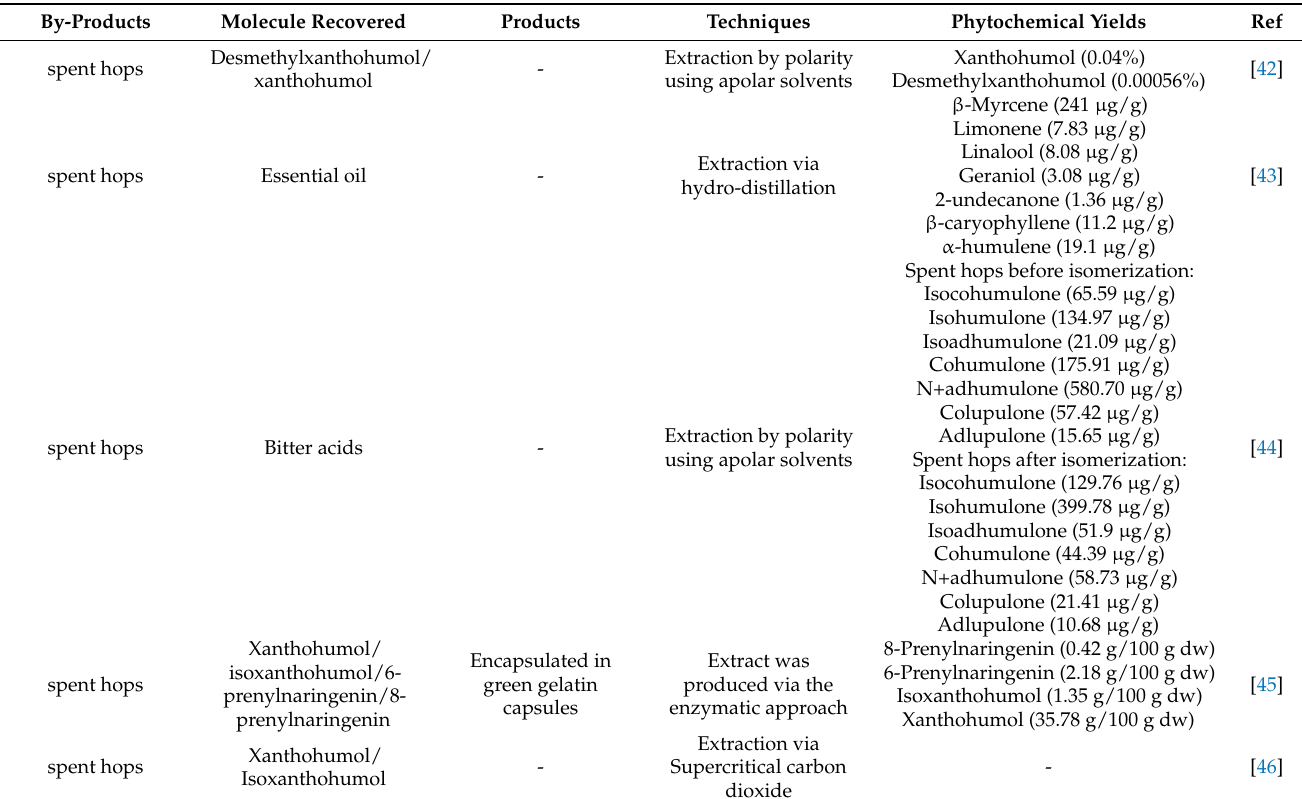
Table 2. Studies about compounds used from hot trub and spent hops that are attractive to the food